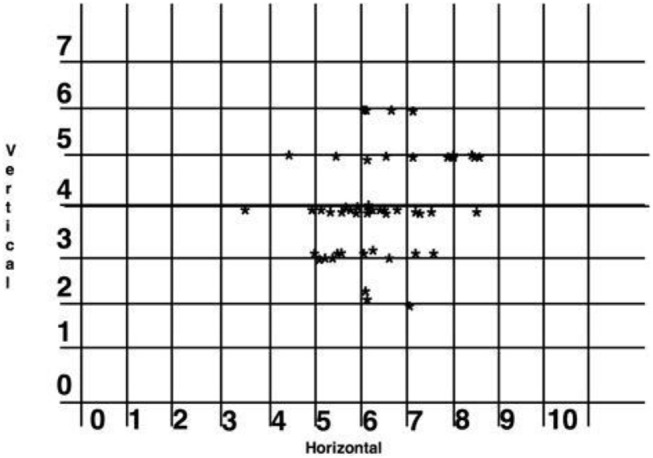
Scatter graph of the horizontal protrusion and vertical dimension of complete responders (in millimeters). One subject was excluded at 11 mm horizontal and 4 mm vertical as lying outside the range.